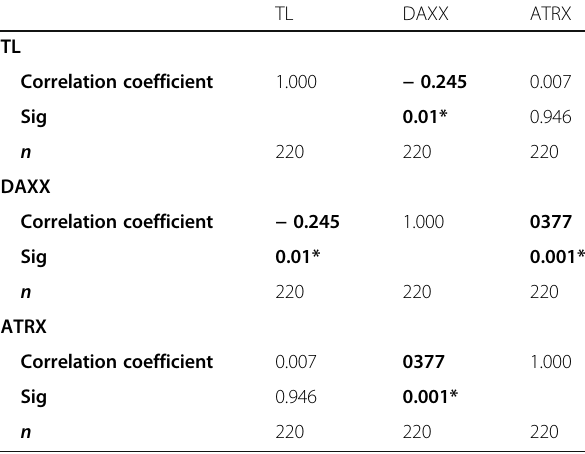
Table 3 correlation between telomere length, ATRX and DAXX protein expression TL DAXX ATRX